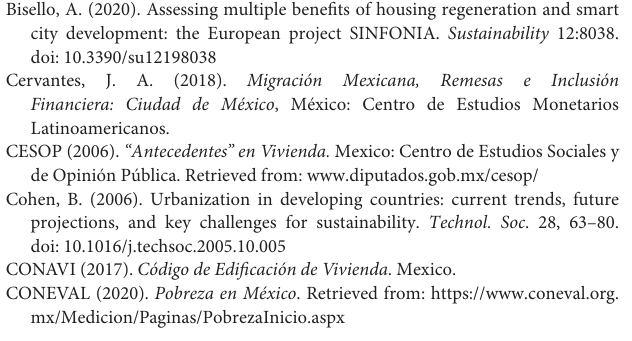
Supplementary Table 1 | Detailed questionnaire structure and description. Supplementary Table 2 | Respondents’ descriptive statistics. Supplementary Table 3 | Households’ general information (descriptive